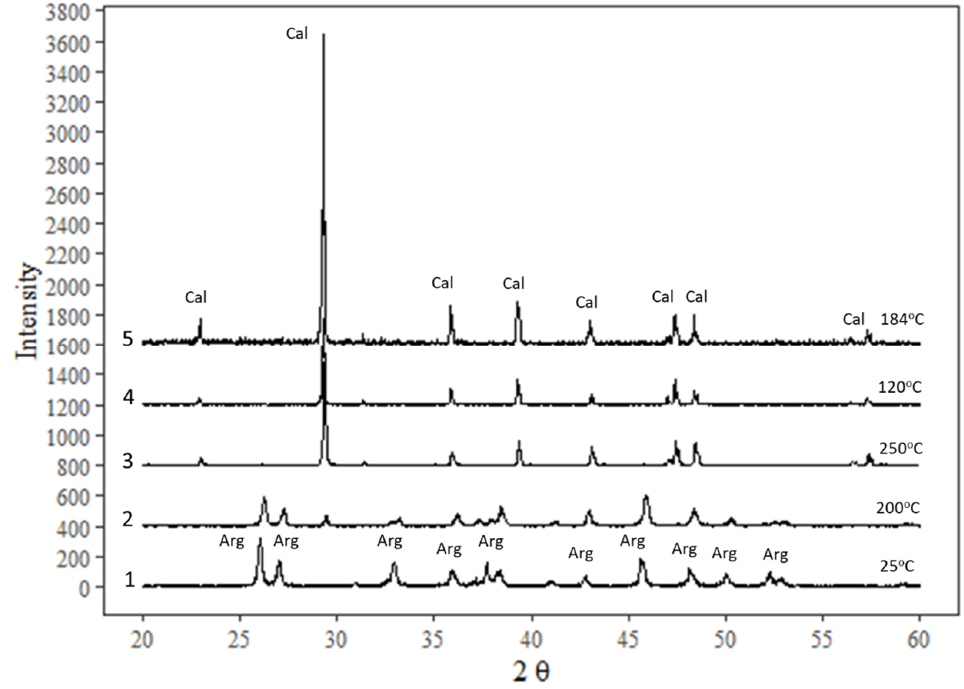
Figure 2. XRD diffractograms of some samples in different range of temperature from 25 °C: ( 1 ) initial aragonite precipitated at 25 °C; ( 2 ) a test of aragonite run at 200 °C in open atmosphere; ( 3 ) aragonite run in water vapor at saturated pressure at 250 °C; ( 4 ) aragonite run in NaCl brine at 120 °C for 30 h; ( 5 ) aragonite run in NaCl brine at 184 °C.